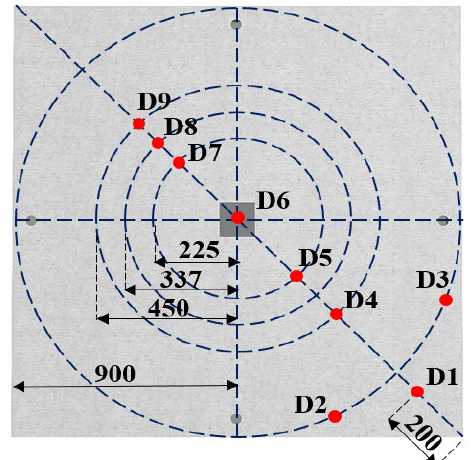
Figure 7. Location of the deflection measurements (units in